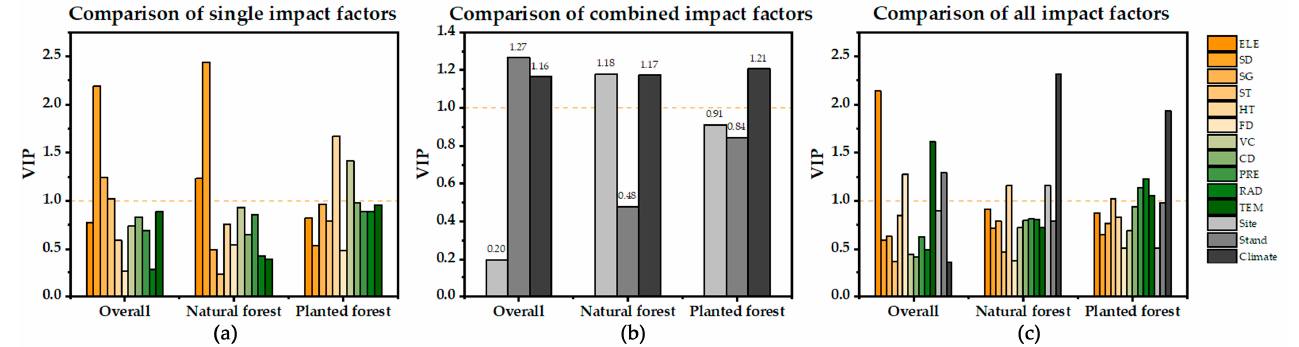
Figure 7. Variable Importance in Projection (VIP) for condition factors. ( a ) shows the comparison of VIP values between single factors for overall, natural forest, and planted forest; ( b ) shows the comparison of VIP values between combined features for overall, natural forest, and planted forest; ( c ) shows the comparison of VIP values between single factors and combined features. Mean elevation (ELE), Slope direction (SD), Slope gradient (SG), Soil thickness (ST), Humus thickness (HT), Forest density (FD), Vegetation cover (VC), Canopy density (CD), Precipitation (PRE), Radiation (RAD), Temperature (TEM).